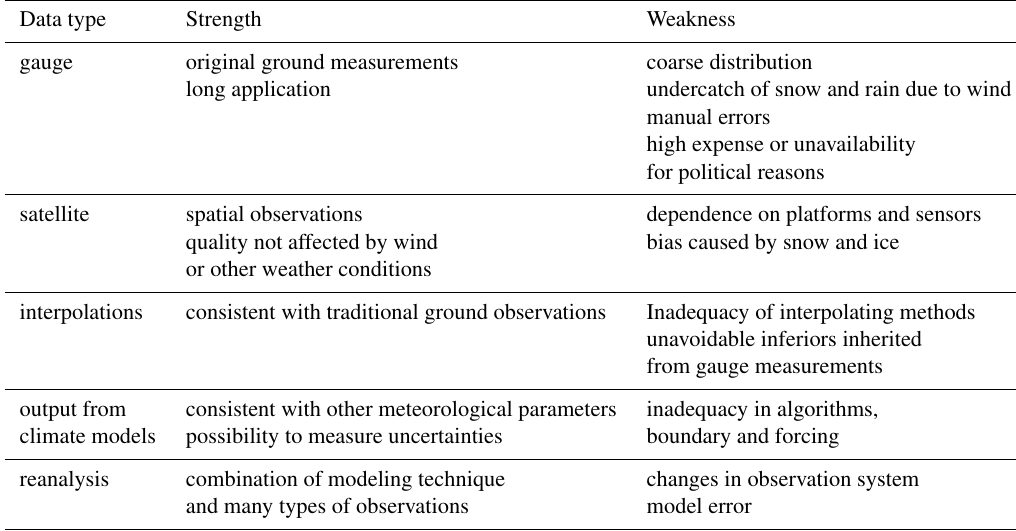
Figure 4. Precipitation (mmmonth − 1 ) for July–August (a, b, c) and November–December (d, e, f) and in three selected longitude bands from west to east (left to right) plotted against latitude. The longitude value of each band is indicated above the figures. The corresponding terrain height (m) in black is displays at the right axis. Table 1. Summary of weaknesses and strength of four types of gridded precipitation